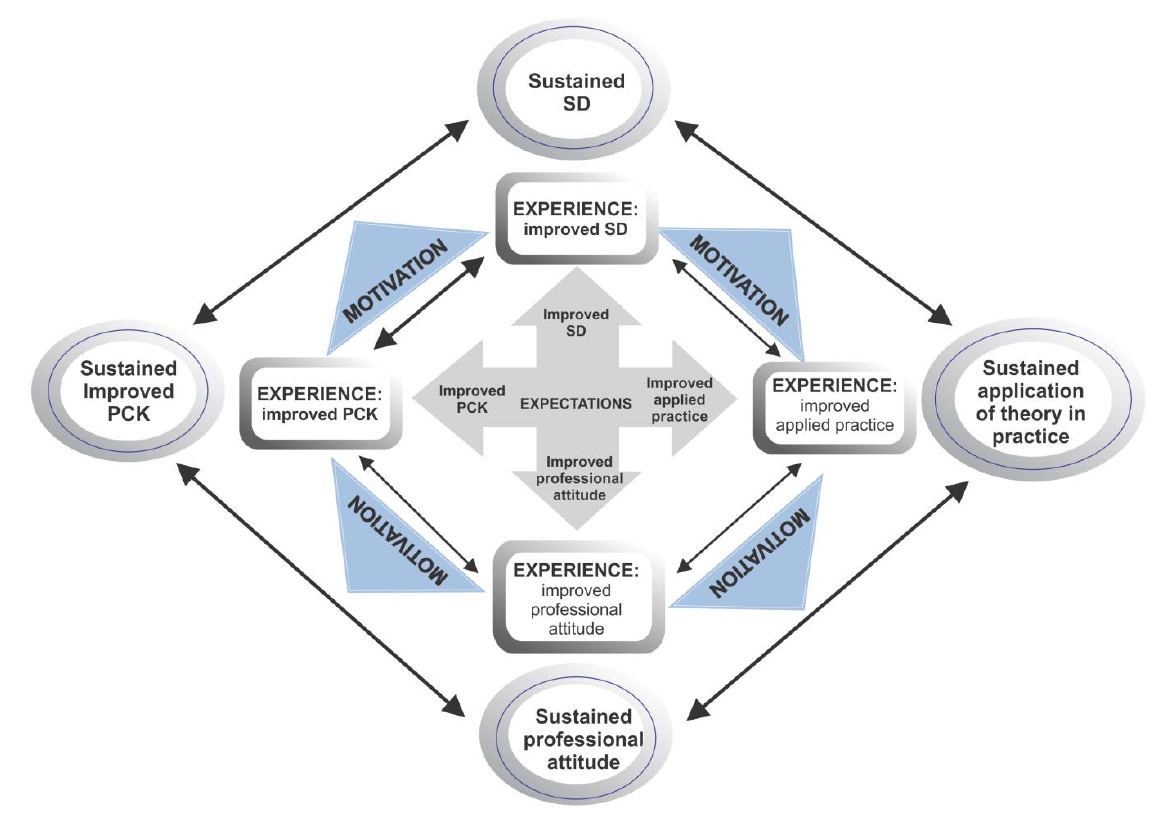
Figure 1. Sustained applied competence model (based on the model by Shulman and Shulman,